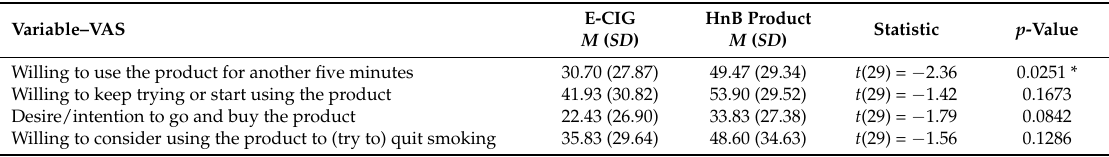
Table A6. T -test results for additional VASs day